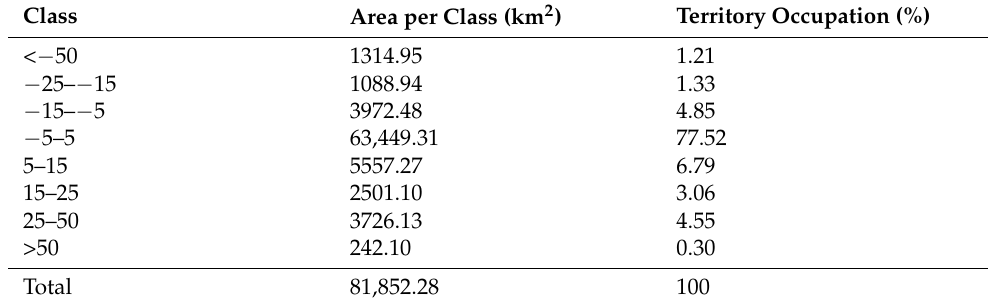
Table 4. Sediment retention change from 1990 to 2018 and the percentage of the total Portuguese territory occupation.